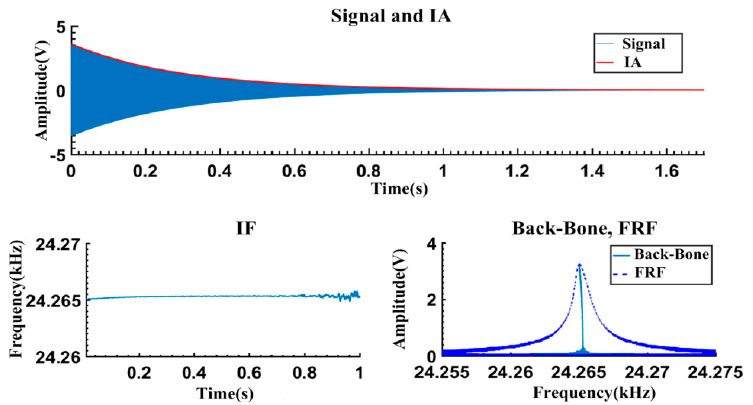
Figure 11. Calculated results for response signals of Figure